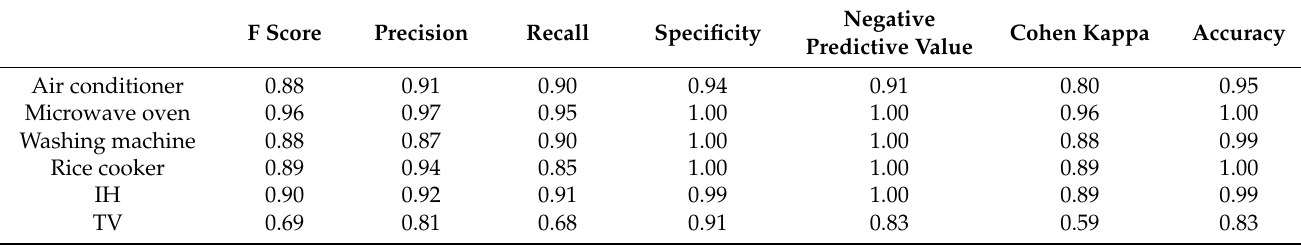
Table A0. Performance of NILM technology for each electric appliance when using testing datasets, based on information from Informetis Co.,